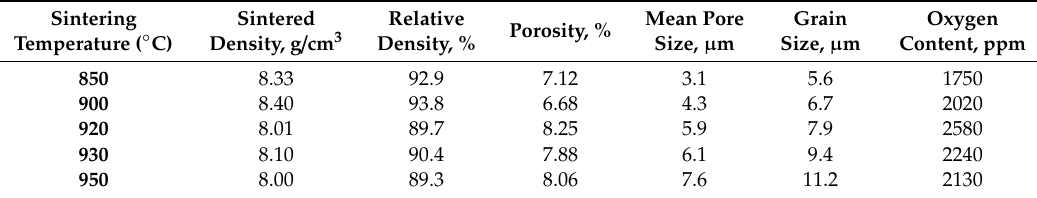
Figure 2. The dilatometry curves of Cu samples sintered at different temperatures. Table 1. Influence of sintering temperature on the density, porosity content, grain size and oxygen content of copper.